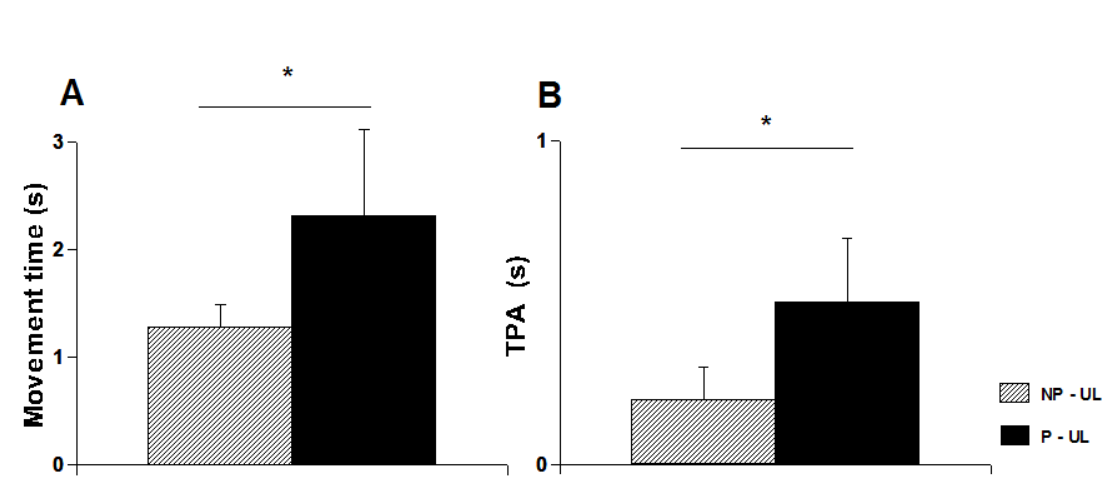
Figure 3. A: Time to reaching movement for paretic (P-UL) and non-paretic upper limb (NP-UL) in subjects with hemiparesis with mild to moderate severity; B:Time to peak acceleration (TPA) in seconds (s) of reaching movement for paretic (P-UL) and non-paretic upper limb (NP-UL) in subjects with hemiparesis of mild to moderate severity, * indicates significant difference ( p